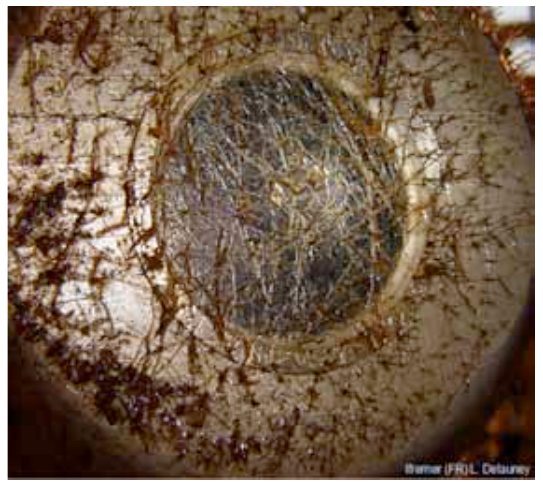
Fig 1 : Fluorometer after Fig 2 : Transmissometer after Fig. 2. Transmissometer after 40 days in Trondheim harbour 30 days in Helgoland (Germany) 40 days in Trondheim (Norway) during during summer harbour (Norway) during summer